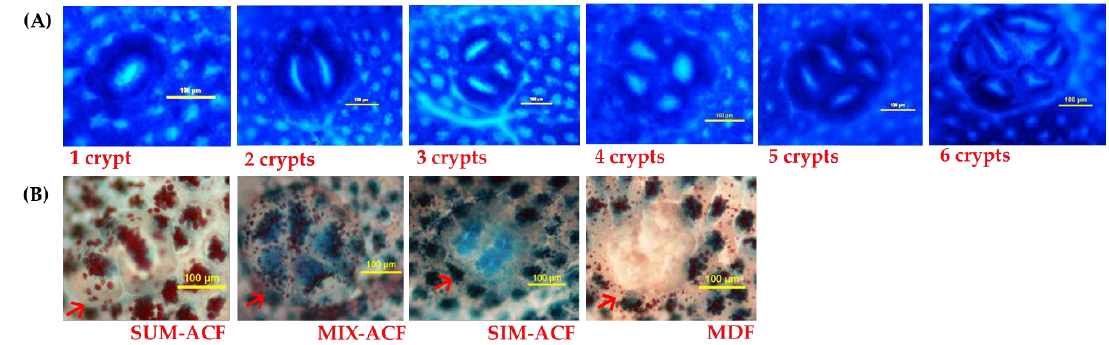
Figure 1. Preneoplastic lesions observed in the colon of F344 rats induced by 1,2-dimethylhydrazine / dextran sulfate sodium (DMH / DSS). ( A ) Methylene blue-stained aberrant crypt foci (ACF) with di ff erent numbers of crypts. ( B ) High-iron diamine alcian blue (HIDAB)-stained ACF with di ff erent types of mucin and mucin-depleted foci (MDF). Table 1. E ff ects of GBR and FGBR on DMH / DSS-induced ACF in the colon of F344 rats 1,2 . ACF with Group 3 Group 3